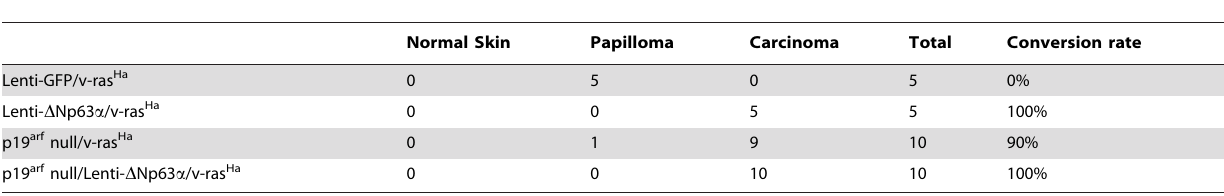
Table 2. Loss of p19 arf cooperates with v-ras Ha in malignant